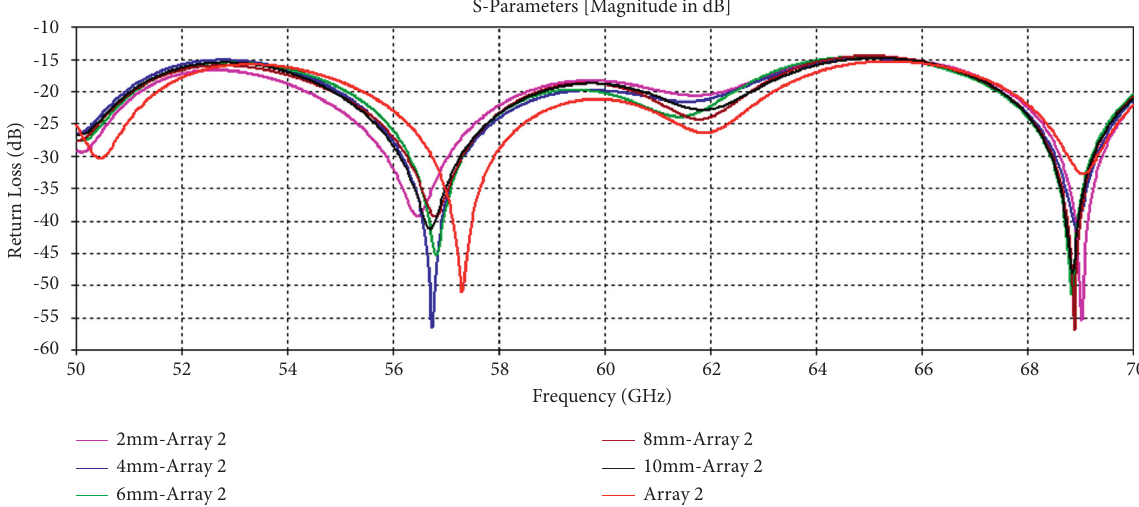
Figure 21: Simulated Array 2 on-body return loss at different distances compared to free